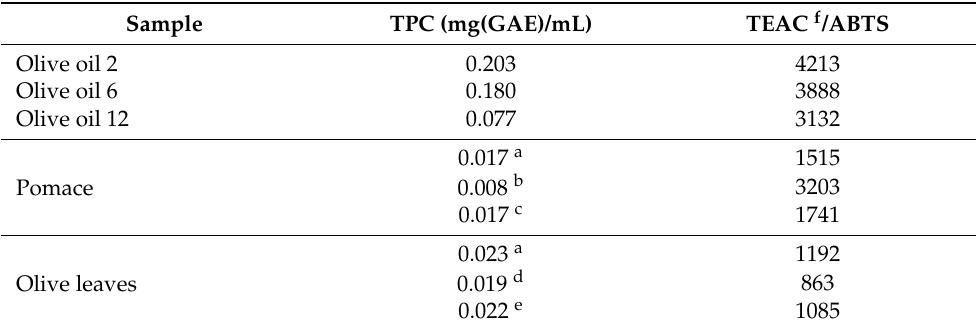
Table 7. TPC and antioxidant